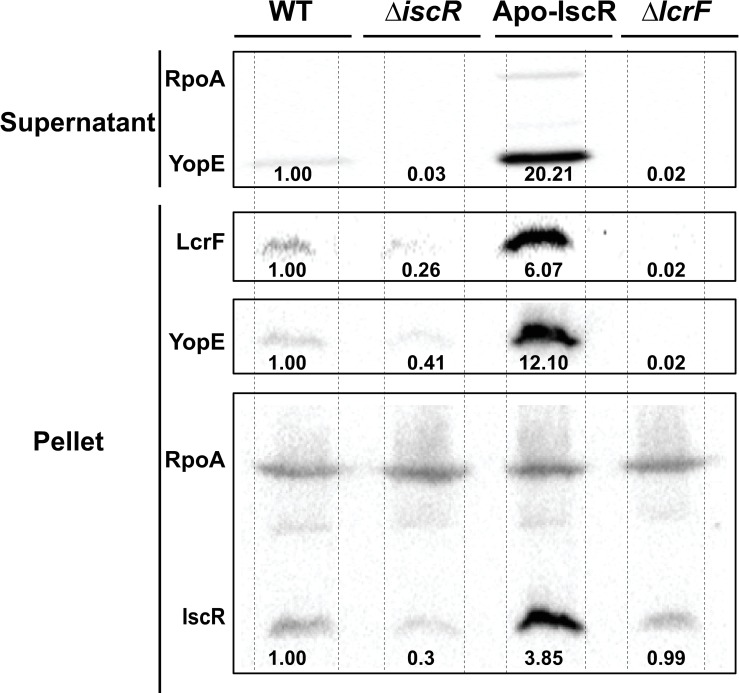
Ectopic expression of IscR is sufficient to rescue T3SS expression under anaerobic, iron-replete conditions.Y. pseudotuberculosis was grown in iron-replete M9/high glucose and in the absence of oxygen and type III secretion induced at 37°C for 4 hrs, as shown in Fig 2. T3SS cargo proteins secreted into culture supernatant and precipitated with TCA were probed with an antibody for YopE. Cell lysates were probed with antibodies for RpoA, IscR, YopE, and LcrF. All samples shown are from the same experiment, with each lysate split into two gels, one subsequently used for LcrF and YopE probing and the other for IscR probing. RpoA was used as a loading control. One representative experiment out of three is shown. Dotted lines delimit the area of each well. Densitometric quantification of the bands was performed using Image Lab software (Bio-Rad), setting the WT band to 1.00.